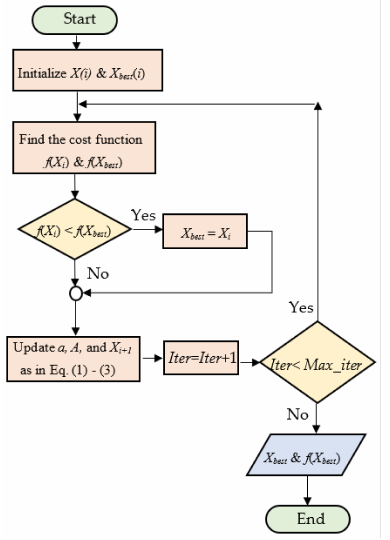
Figure 1. Flowchart of the integer search